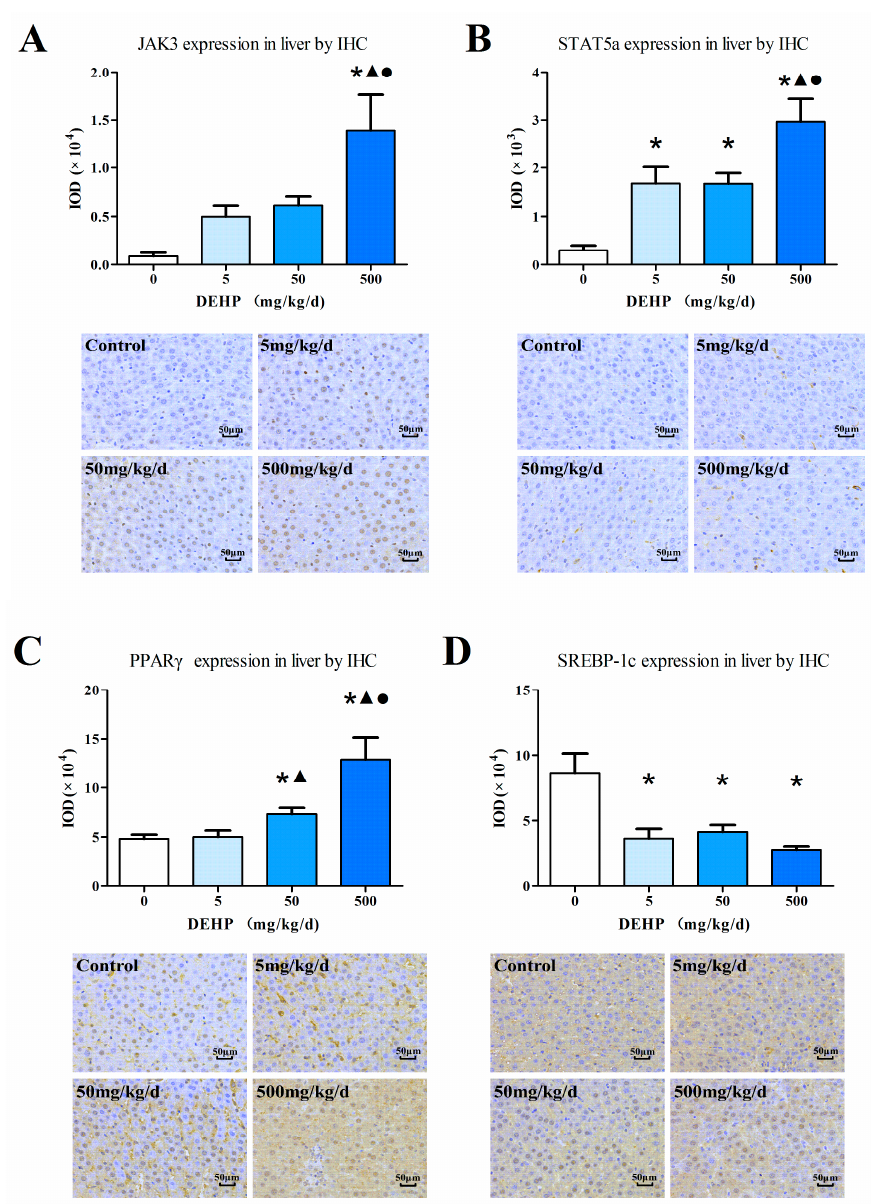
Figure 4. Immunohistochemical determination of proteins in the liver ( n = 20 animals/each group): ( A ) Immunohistochemical staining of JAK3 expression in the liver (400 × ); ( B ) Immunohistochemical staining of STAT5a expression in the liver (400 × ); ( C ) Immunohistochemical staining of PPAR γ expression in the liver (400 × ); ( D ) Immunohistochemical staining of SREBP-1c expression in the liver (400 × ); Brown staining indicates areas of positive protein expression. Results were expressed as the mean ± SE ( n = 20 animals/treatment group). • Statistically significant difference compared with 50 mg·kg − 1 ·d − 1 ( p < 0.05); ▲ Statistically significant difference compared with 5 mg·kg − 1 ·d − 1 ( p < 0.05); * Statistically significant difference compared with control ( p < 0.05).